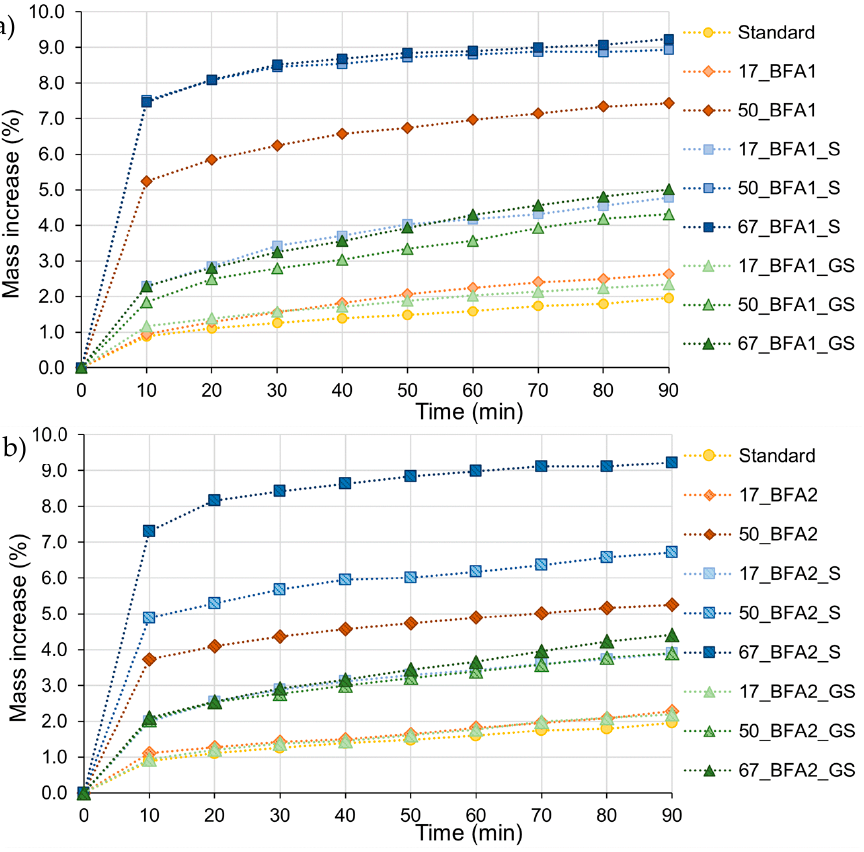
Figure 6. Capillary water absorption of the mortars (cured for 28 days) prepared with: ( a ) BFA1 and ( b ) BFA2.